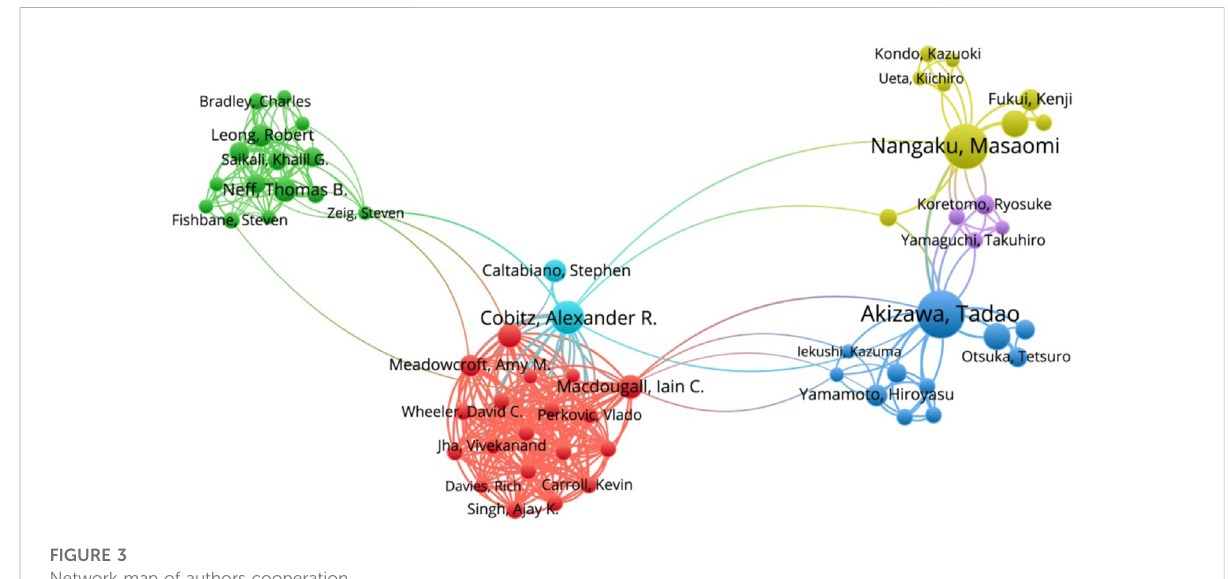
FIGURE 3 Network map of authors cooperation.